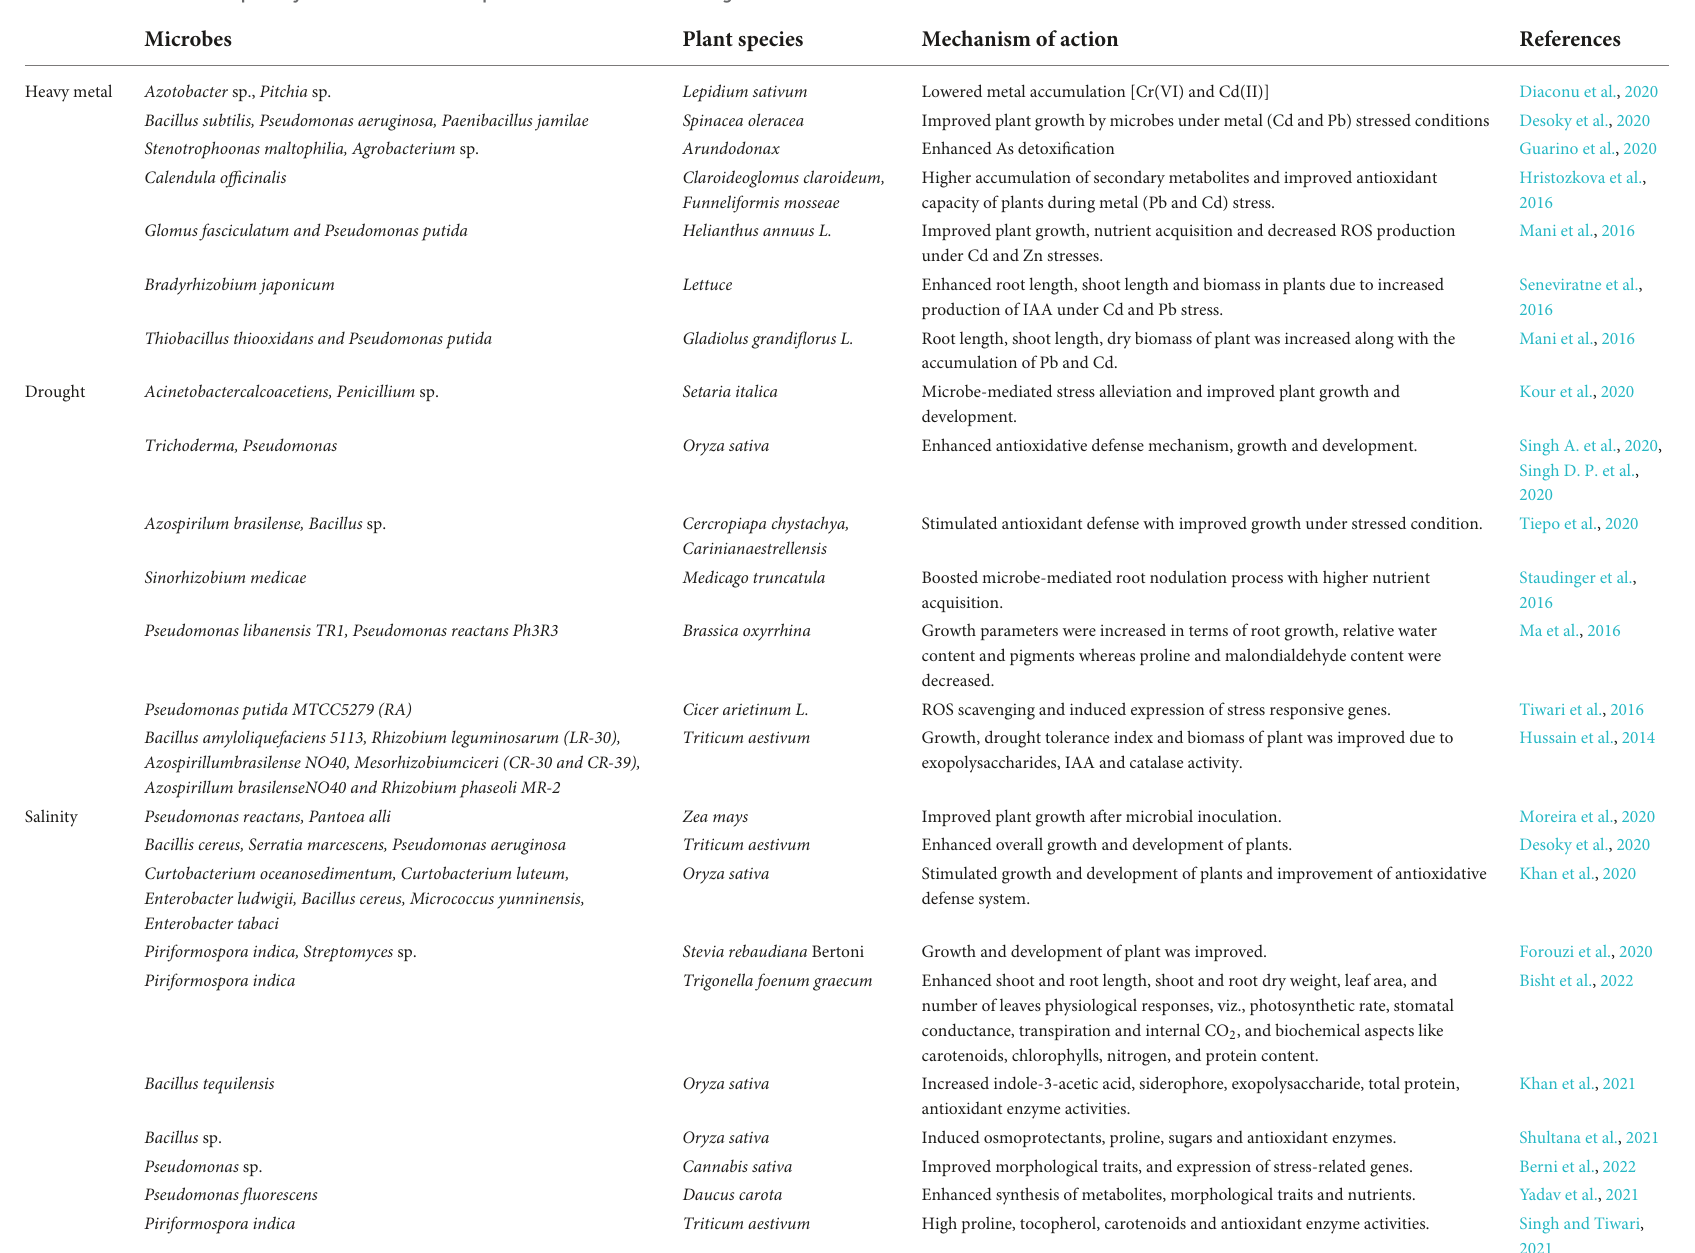
TABLE 2 Mechanisms adopted by different microbes in plants for abiotic stress